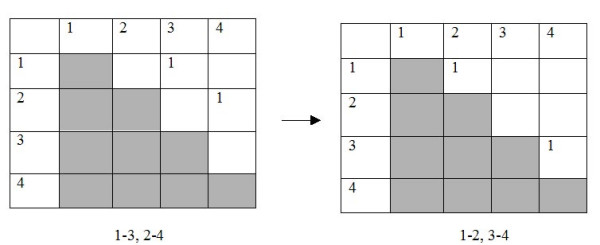
Adjacency matrices of two disulfide topologies of a peptide with two disulfide bridges